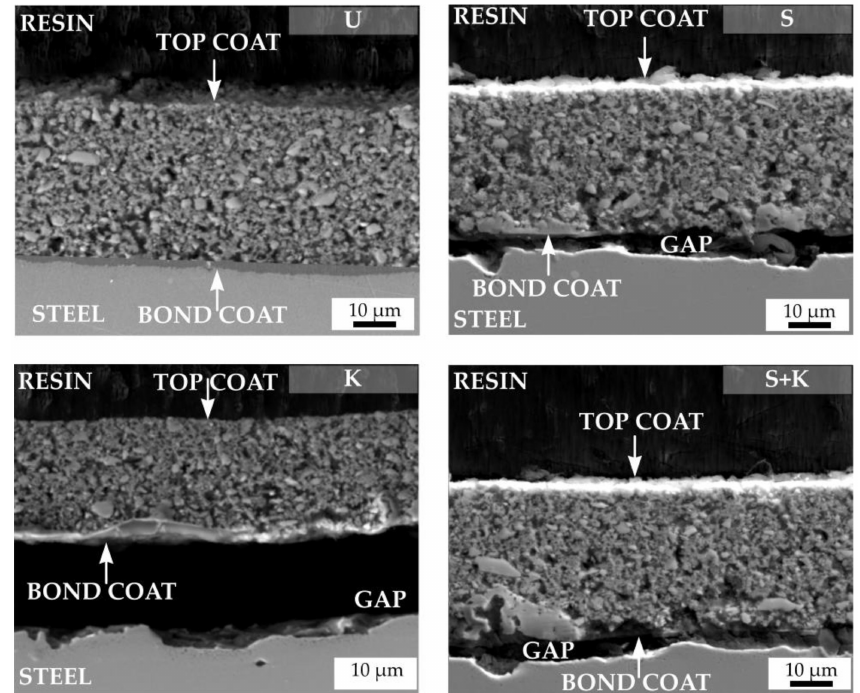
Figure 12. Cross sections of D2-PP coatings after oxidation tests. The applied cleaning procedure is indicated by the abbreviation in the upper right corner of each figure (U – ultrasonic cleaning, K